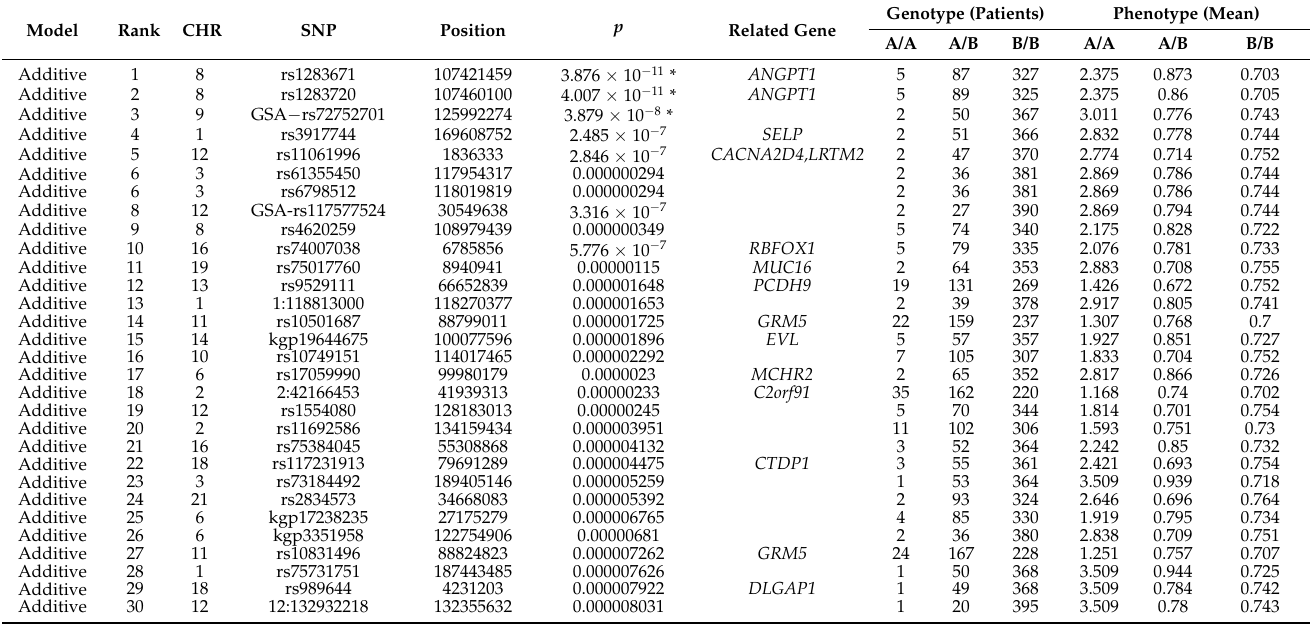
Table 2. Top 30 candidate SNPs selected from the GWAS (additive model).